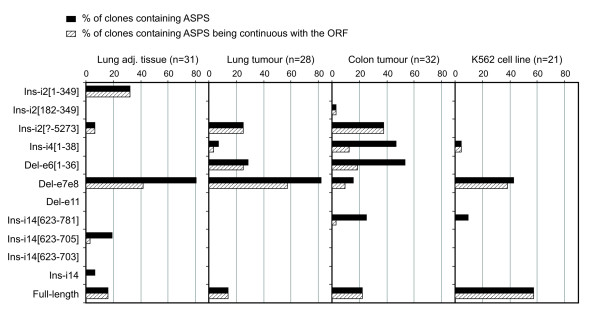
Frequency of hTERT mRNA ASPSs in RT-PCR cDNA clones. The tissue of origin is indicated above the graph with number of analysed clones in brackets. Black bars show the percentage of clones containing the indicated ASPS. The fraction of these for which the 5'-splice donor site is continuous with the ORF (not masked by other ASPSs further upstream that terminate the ORF) is shown by an adjacent cross-hatched bar.